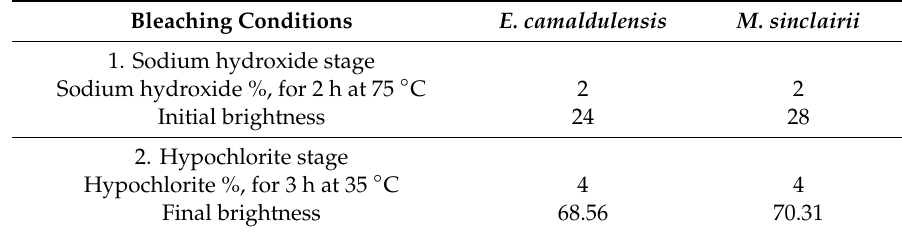
Table 1. Conventional bleaching conditions of wood branch (WB) pulp from E. camaldulensis and M. sinclairii